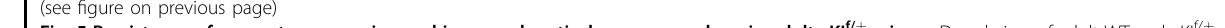
mouse brain. Orange and red lines illustrate the measurements of neocortex width and length. Scale bar, 2 mm. b , c Quanti fi cation for neocortex width, length and area ( n = 3). d DAPI staining of adult WT and cKI f/ + mouse neocortex. Arrows indicate gyri fi cation structures. The dashed white lines show the boundary of cortex. e Representative DAPI staining of adult WT and cKI f/ + mouse neocortex illustrating the measurements of cortical thickness (red) and perimeter (orange). Scale bar, 1 mm. f , g Quanti fi cation for cortical thickness ( n = 3) and perimeter ( n = 4) in the rostral part of adult WT and cKI f/ + mouse brain. h – j IF for SATB2, CUX1 and CTIP2, combined with DAPI staining of adult WT and cKI f/ + mouse neocortex. Scale bars, 50 μ m. k Quanti fi cation for zone thickness of adult WT and cKI f/ + mouse neocortex ( n = 3). l – n Quanti fi cation for SATB2 + , CUX1 + and CTIP2 +